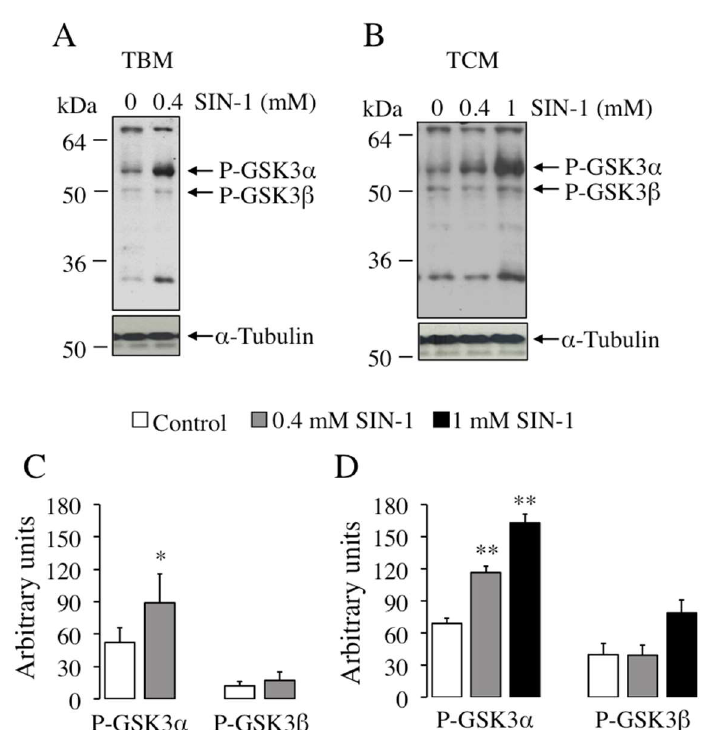
Figure 9. Effect of SIN-1 induced-peroxynitrite in the phosphorylation of GSK-3 on boar spermatozoa. Spermatozoa were incubated in TBM ( A ) or TCM medium ( B ) at the indicated concentrations of SIN-1 at 38.5 °C for 1 h and sperm proteins (15 μg) analyzed by Western blotting using anti-phospho GSK-3α/β as primary antibody (upper films). These experiments were performed 4 times and representative films are shown. Loading controls using anti-α-tubulin antibody (lower films) were performed for each experiment in the same membrane. Figures C and D correspond to the quantification of bands in A and B , respectively. Arrows indicate the cross-reactive sperm bands corresponding to phosphorylated GSK-3α (P-GSK-3α) and GSK-3β (P-GSK-3β) and also α-tubulin. Densitometry analysis of each band is shown at the bottom image, values are expressed as arbitrary units; mean ± SEM. Statistical differences are shown with **( p < 0.01) and *( p < 0.05).